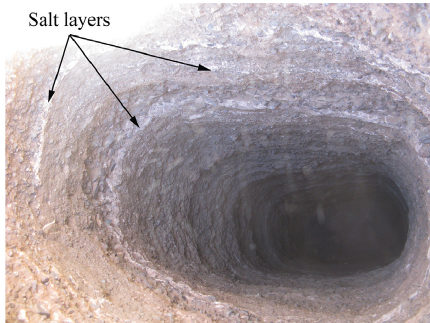
Figure 1: Strata feature for coarse-grained saline soils.